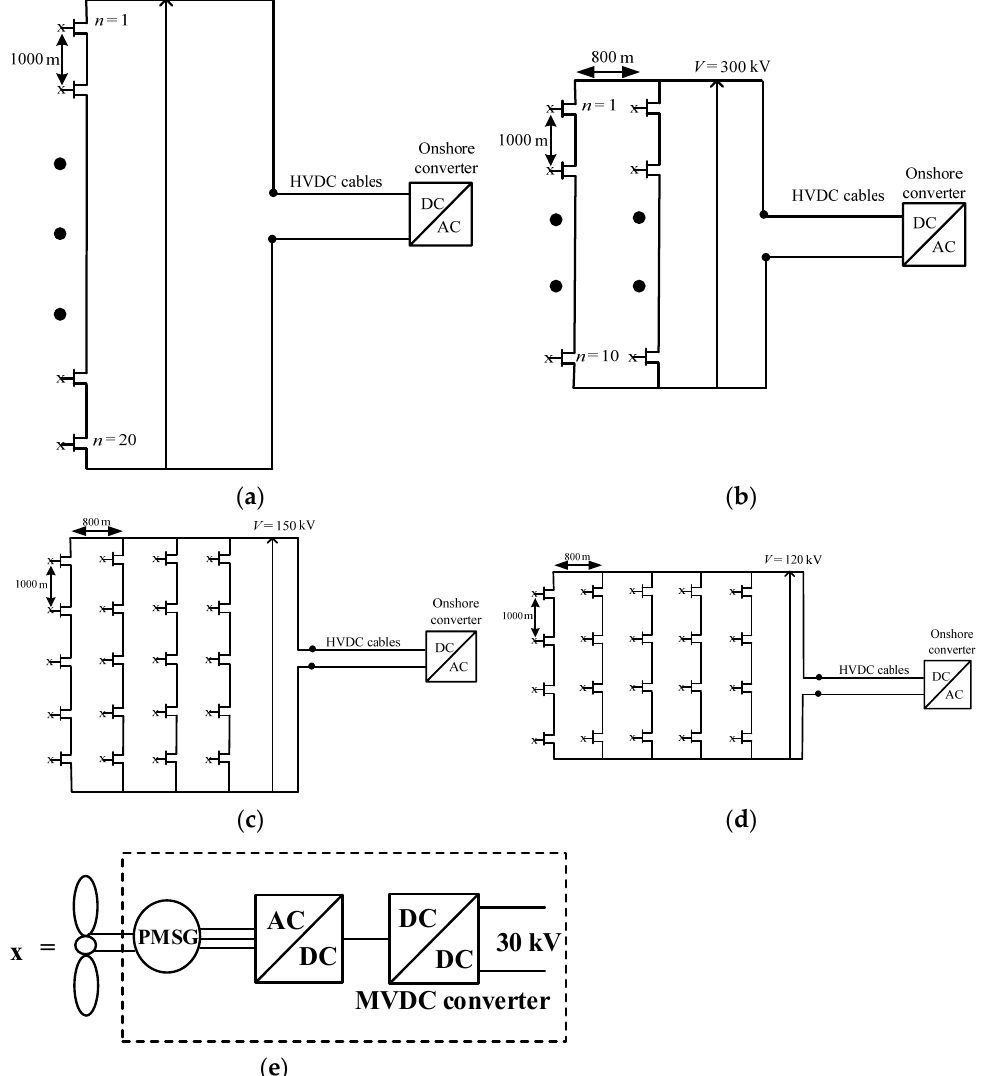
Figure 3. Configuration of the wind farms considered for the case study with DC series–parallel collection systems. ( a ) 20 × 1 turbines (pure DC series wind farm with a single string and 20 turbines connected in a series, HVDC voltage: 600 kV) ( b ) 10 × 2 turbines (DC series–parallel wind farm with 2 strings and each string with 10 series-connected turbines, HVDC voltage: 300 kV) ( c ) 5 × 4 turbines (DC series–parallel wind farm with 4 strings and each string with 5 series-connected turbines, HVDC voltage: 150 kV) ( d ) 4 × 5 turbines (DC series–parallel wind farm with 5 strings and each string with 4 series-connected turbines, HVDC voltage: 120 kV). ( e ) Generators and power conversion components in an individual wind turbine.